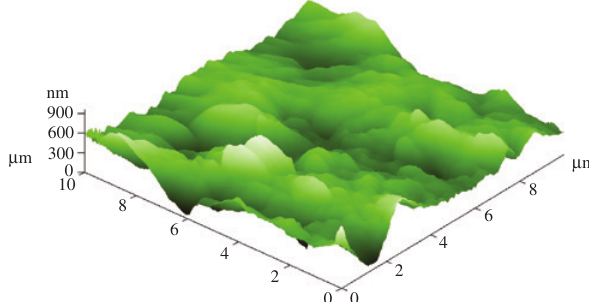
Figure 24: AFM analysis of GFRP with 3% CNTs–3D analysis.